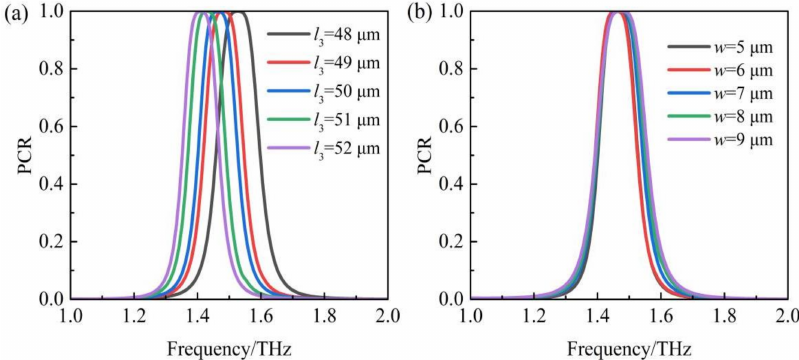
Figure 7. ( a ) Polarization conversion efficiency of the device with gold square aperture ring structure with parameter l 3 ; ( b ) polarization conversion efficiency of the device with gold square aperture ring structure with parameter w